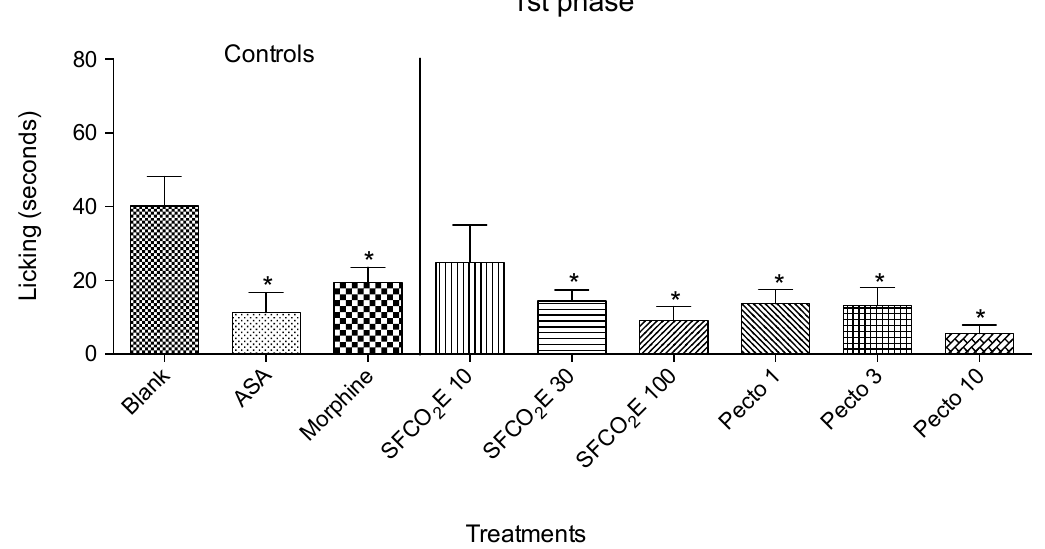
Figure 2. The results from the first phase of formalin of treated mice (santonin-free CO2 subcritical extract (SFCO 2 E) at 10, 30, and 100 mg/kg or pectolinarigenin (Pecto) at 1, 3, and 10 mg/kg) were compared with mice that were given vehicle (blank), ASA (200 mg/kg) or morphine (2.5 mg/kg) used as positive controls. This figure shows the decrease of the bar against the untreated mice. The treatments which show a significant decrease in the bar size compared to blank are marked with (*), p < 0.05. In the second phase of the formalin test, all SFCO 2 E concentrations tested (10, 30, and 100 mg / kg) and all pectolinarigenin concentrations tested (1, 3, and 10 mg / kg) showed a significant reduction in the licking time (Figure 3).